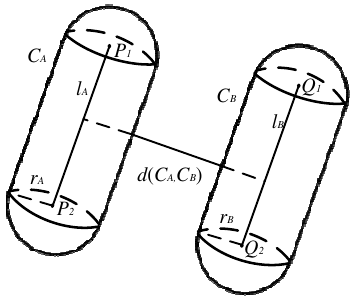
Figure 10. Capsule body space distance.